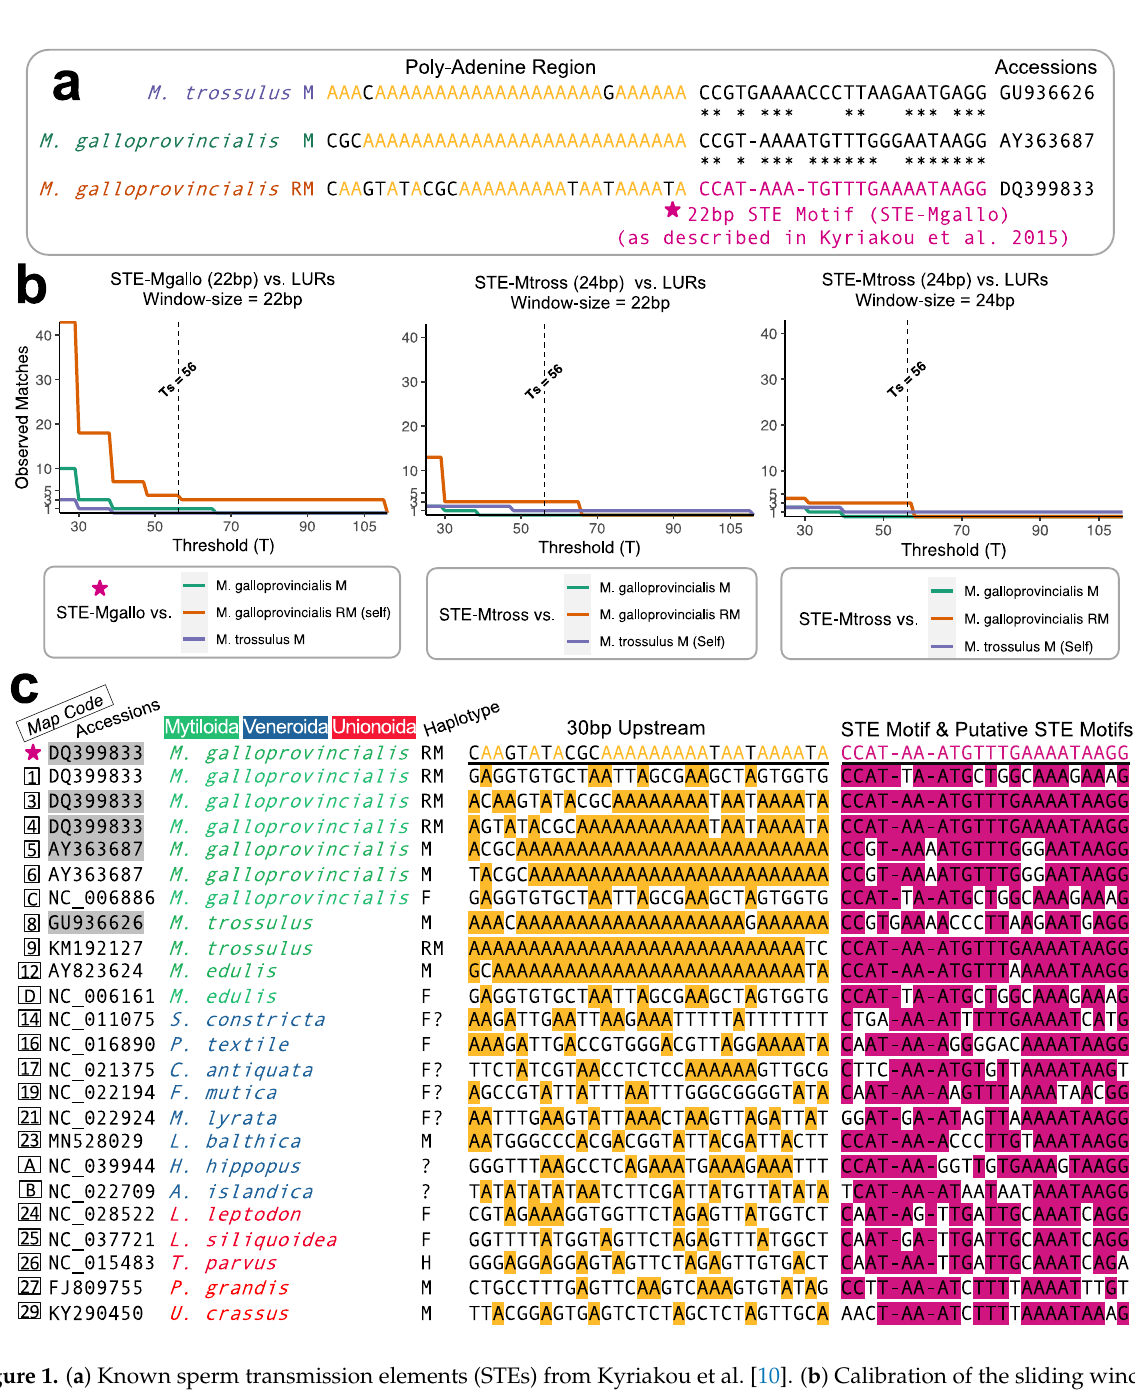
algorithm [27] and then conserved nucleotide positions highlighted. The sequence simi ‐ larity between each putative STE and the known 22 bp STE motif was further plotted from this alignment using the ggplot2 [28] and ggrepel [29] packages in R version 4.0.3 [30] via